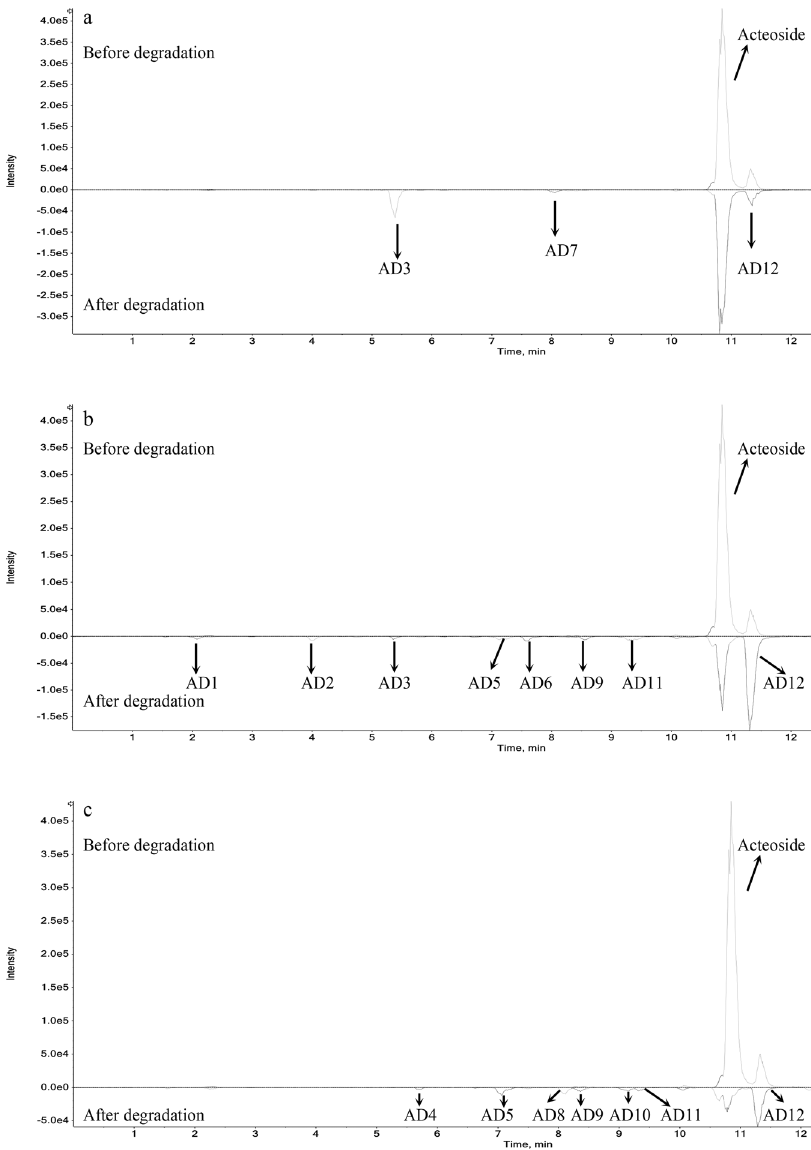
Figure 4. Total ion chromatograms of acteoside before and after degradation in negative ion mode in different storage conditions. ( a ) In common storage conditions (temperature ≤ 37 °C, pH ≤ 7); ( b ) at high temperature; ( c ) at high pH. AD: acteoside degradation